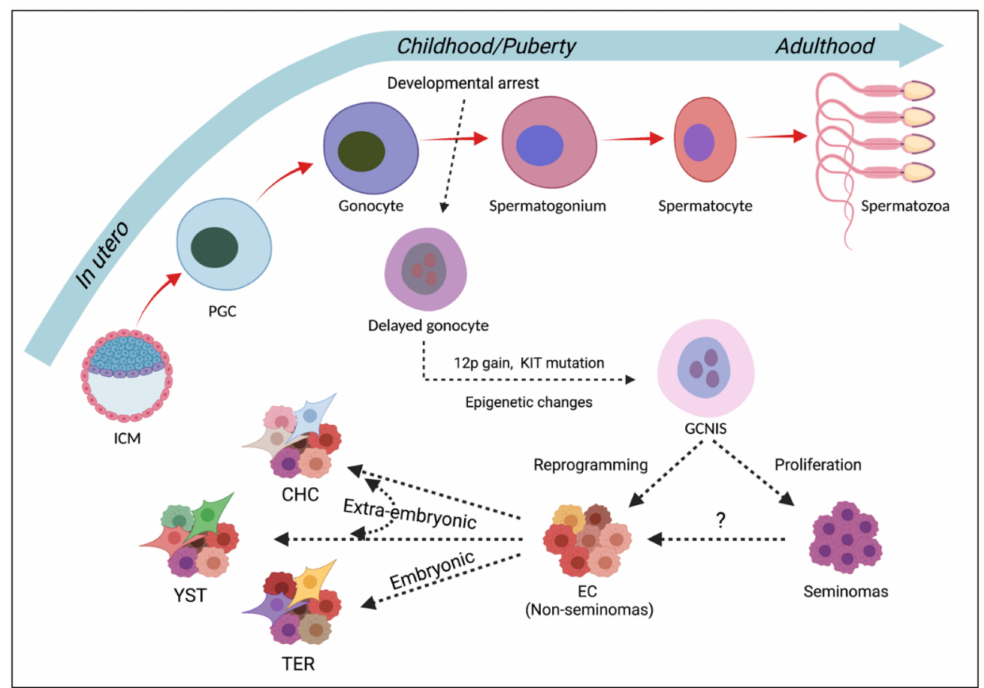
Figure 1. Germ cell development vs. TGCT development. ICM—inner cell mass, PGC—primordial germ cell, GCNIS—germ cell neoplasia in situ, EC—embryonal carcinoma, CHC—choriocarcinoma, YST—yolk sac tumour,